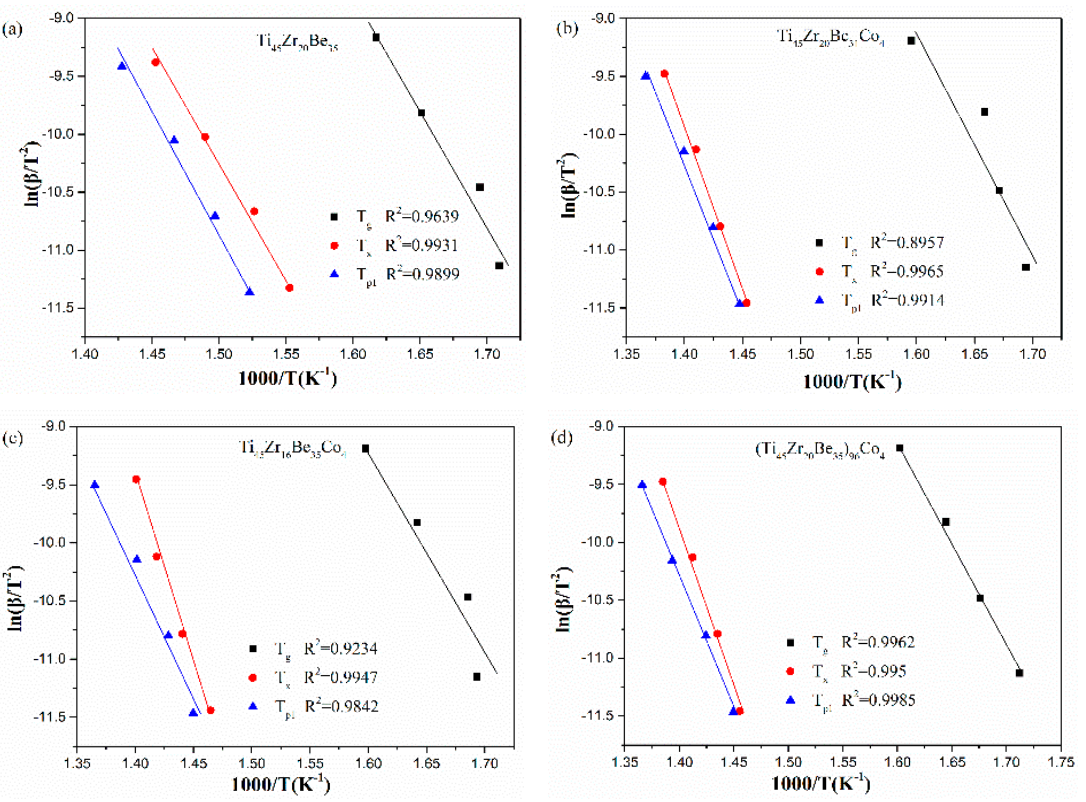
Figure Figure 9. Kissinger plots for ( a ) Ti 45 Zr 20 Be 35 , ( b ) Ti 45 Zr 20 Be 31 Co 4 , ( c ) Ti 45 Zr 16 Be 35 Co 4 , and ( d ) (Ti 45 Zr 20 Be 35 ) 96 Co 4 BMGs. Table 5. The values of E g and E x calculated by Kissinger and Moynihan equations.